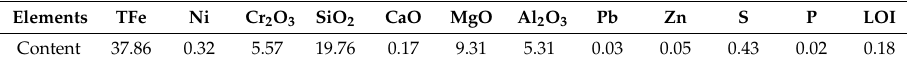
Table 1. Chemical compositions of nickel slag (wt %).